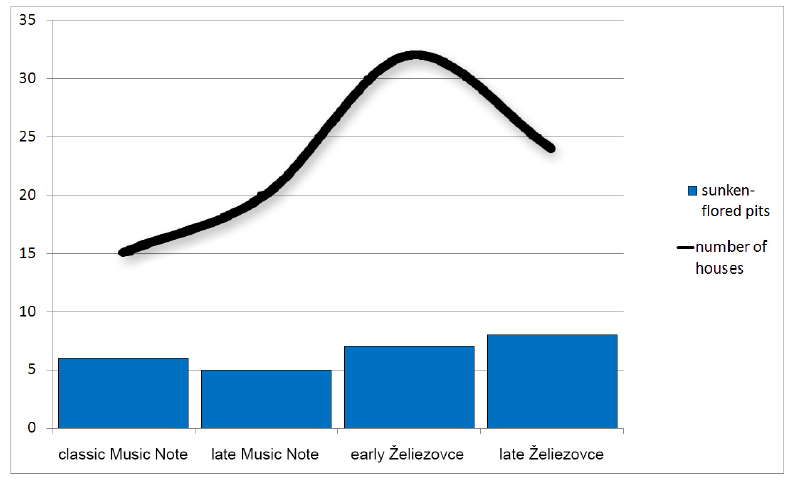
Figure 9: The comparison of a number of the sunken-floored buildings and longhouses in various stages of